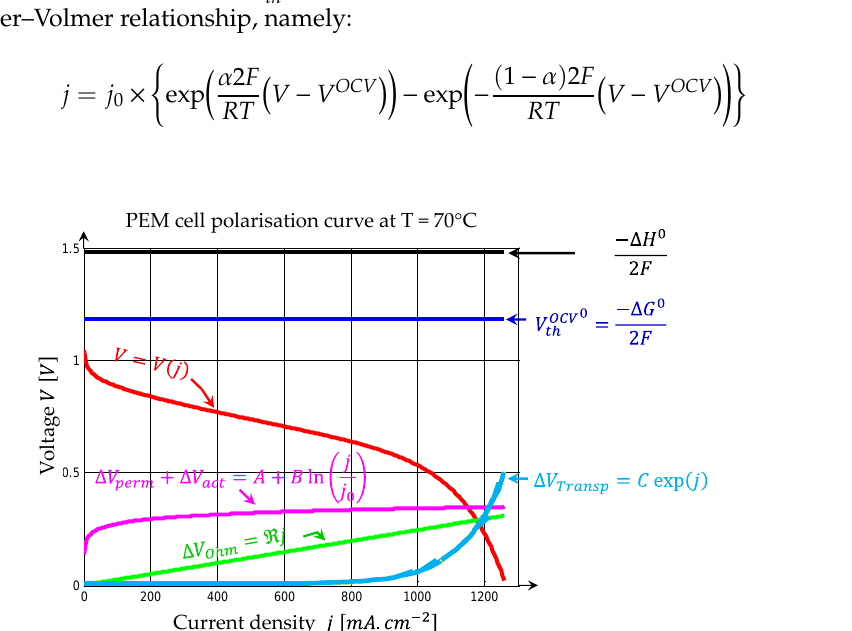
Figure 6. FC voltage and the main related voltage drops (due to irreversibilities).